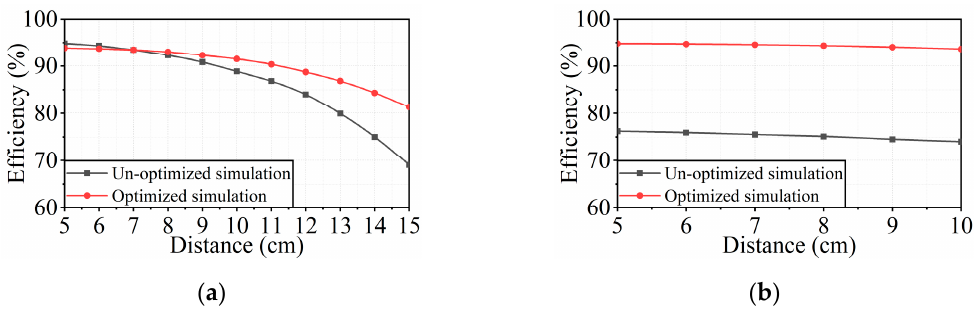
Figure 15. PTE curves with unoptimized and optimized coils: ( a ) UAV to sensor; ( b ) ground transmitting side to UAV.